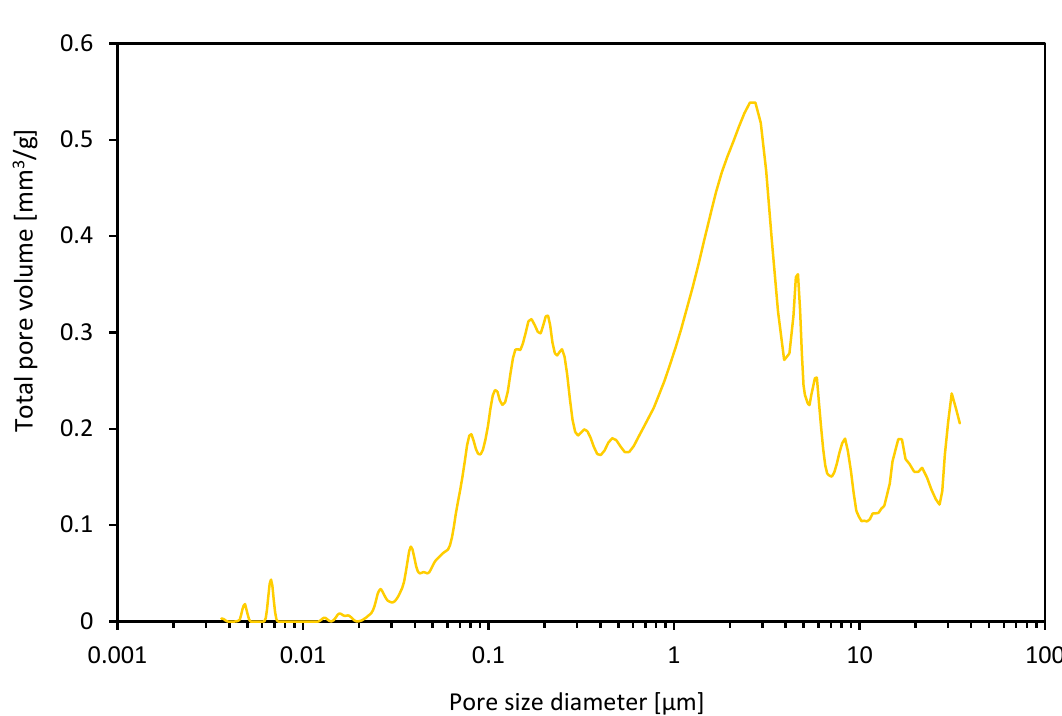
Figure 13. Magnesite from Wiry. Pore volume distribution as a function of their diameter after the decarbonation process.